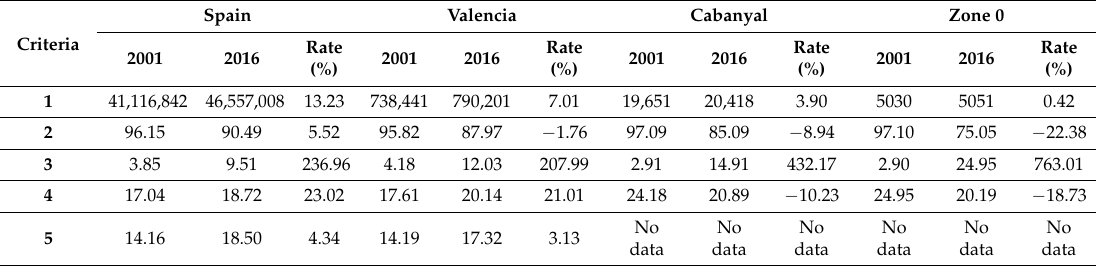
Table 1. Socioeconomic criteria in different analysis